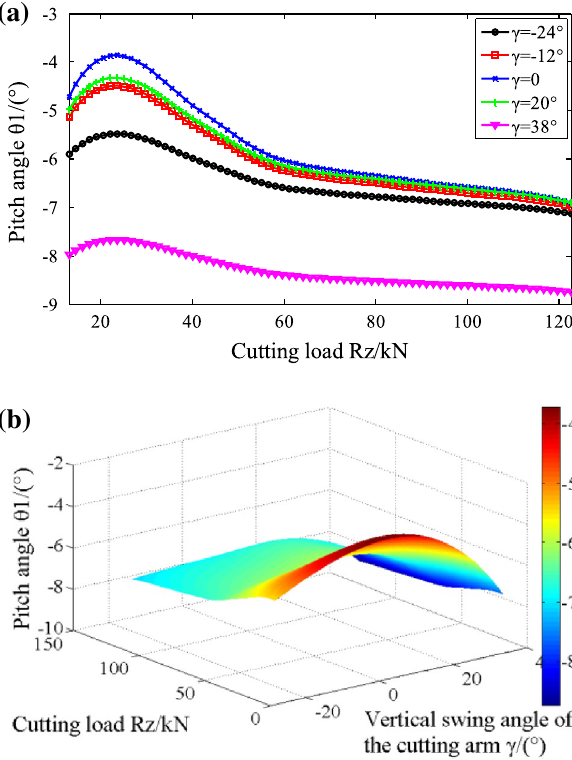
Fig. 12 Response regularities of the deviation angle during the horizontal cutting process. ( a ) Relationship between the deviation angle and cutting load; ( b ) Relationship of the deviation angle, cut- ting load and horizontal swing angle of the cutting arm